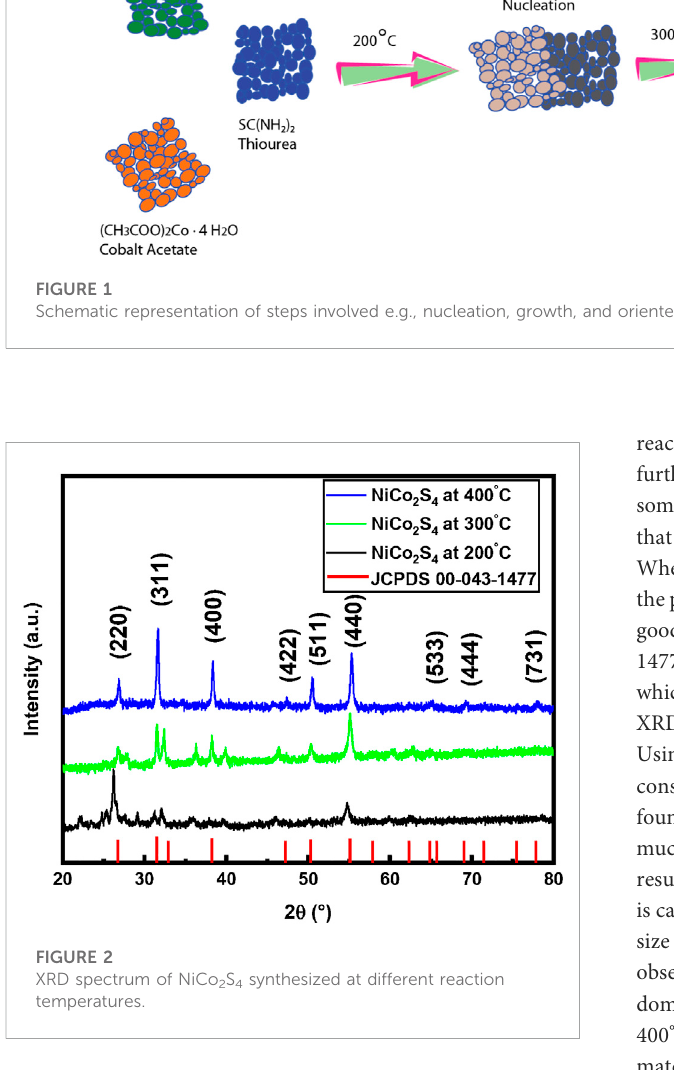
shows the XRD spectrum of NiCo 2 S 4